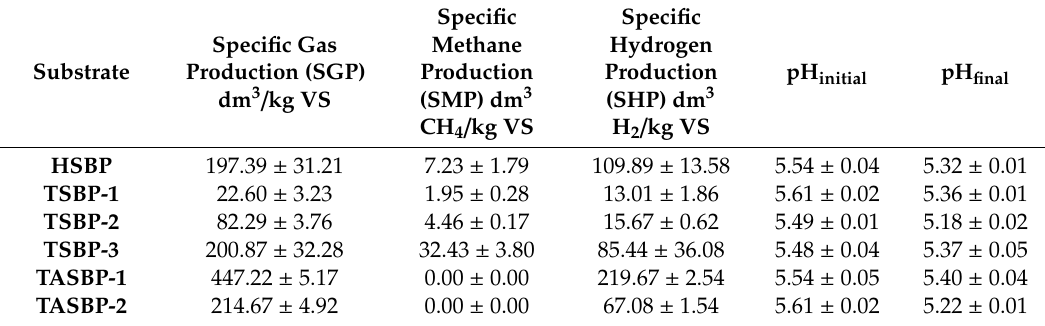
Table 3. Parameters of the batch digestion tests with pH adjustment and thermal pretreatment.